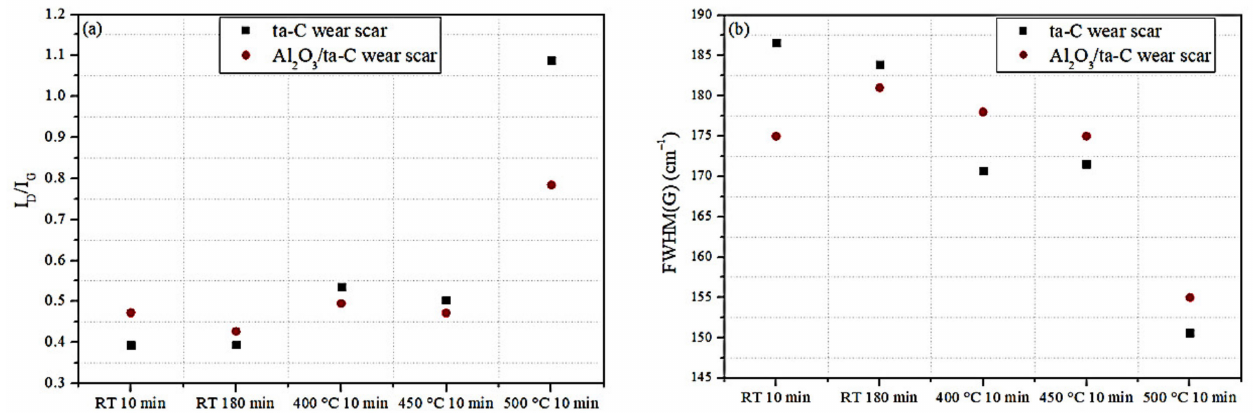
Figure 9. Summary of the results of the Raman spectroscopy investigations within the wear scars: ( a ) I D /I G ratio and ( b )